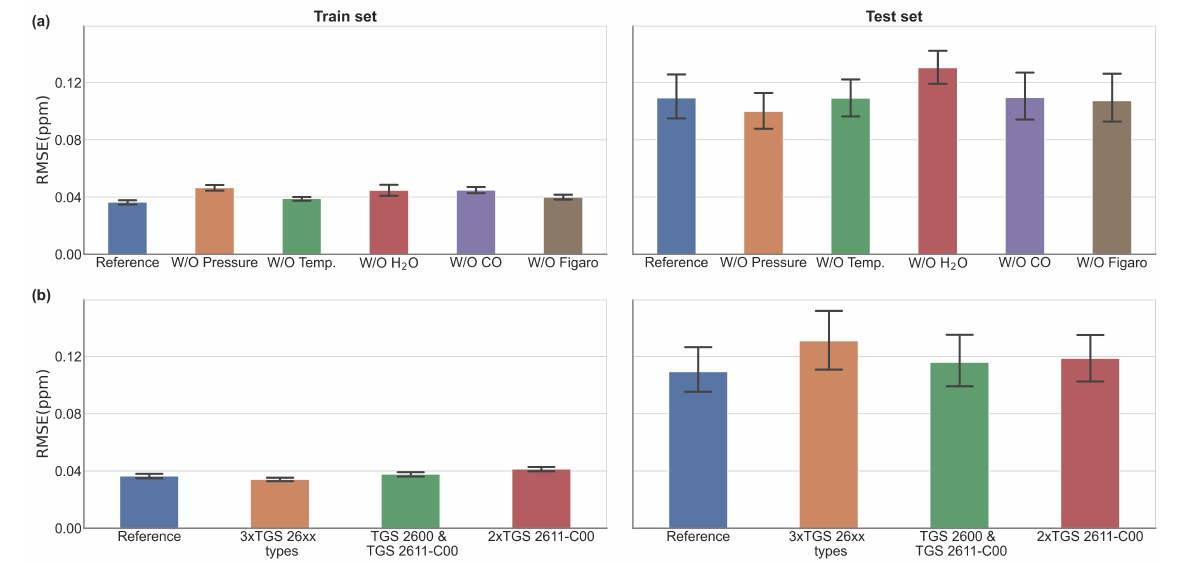
Figure 9. ( a ) Comparison of 5 models in which one input has been removed at each time (denoted ‘W/O’) with the reference model that has been built with the resistance data of the Figaro TGS 2611-C00 and the 4 other types of data (Reference). ( b ) Effect of increasing the number of Figaro ® sensors in the model with no modification of the ambient variables in the input. The bar plot represents the mean error for every configuration and the error bar on top is the range of variation over the 50 validation